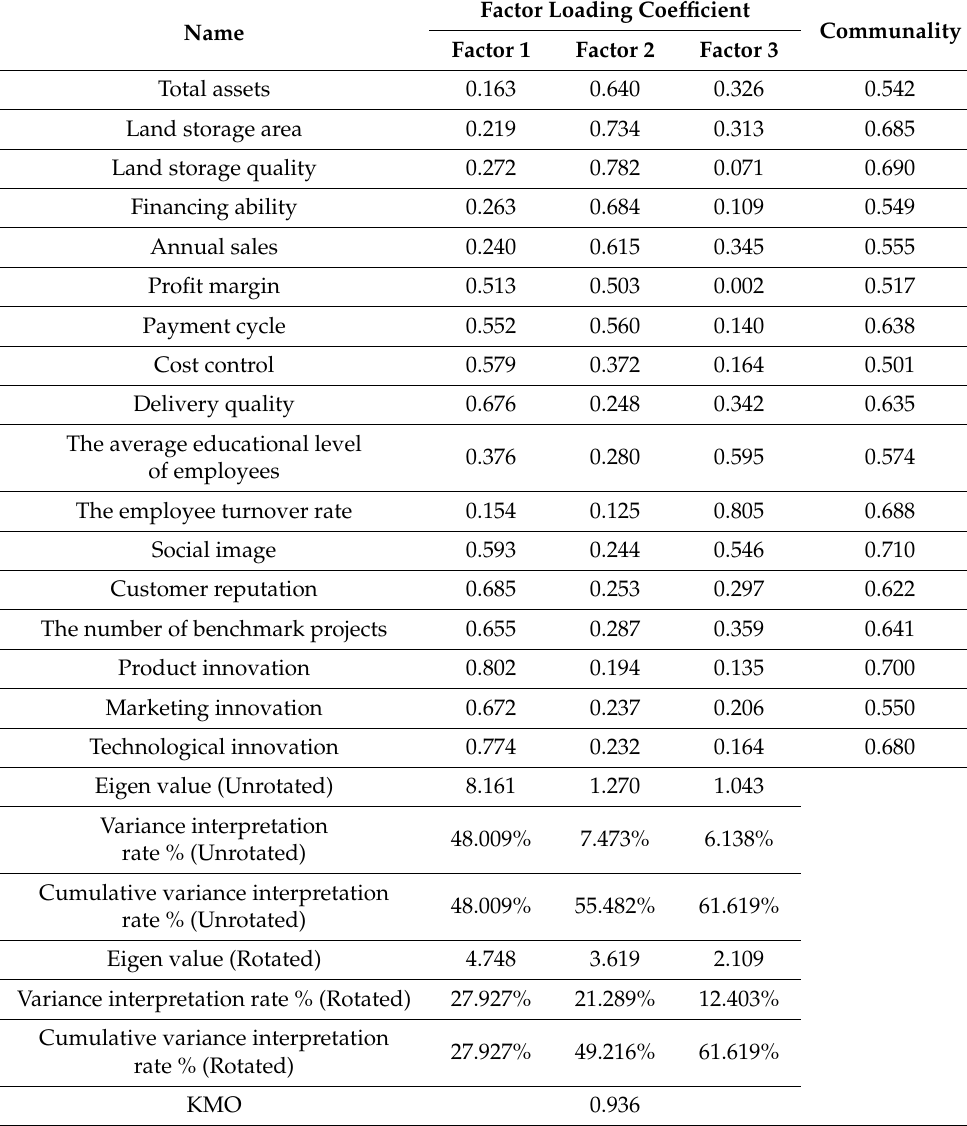
Table 5. Validity test of the